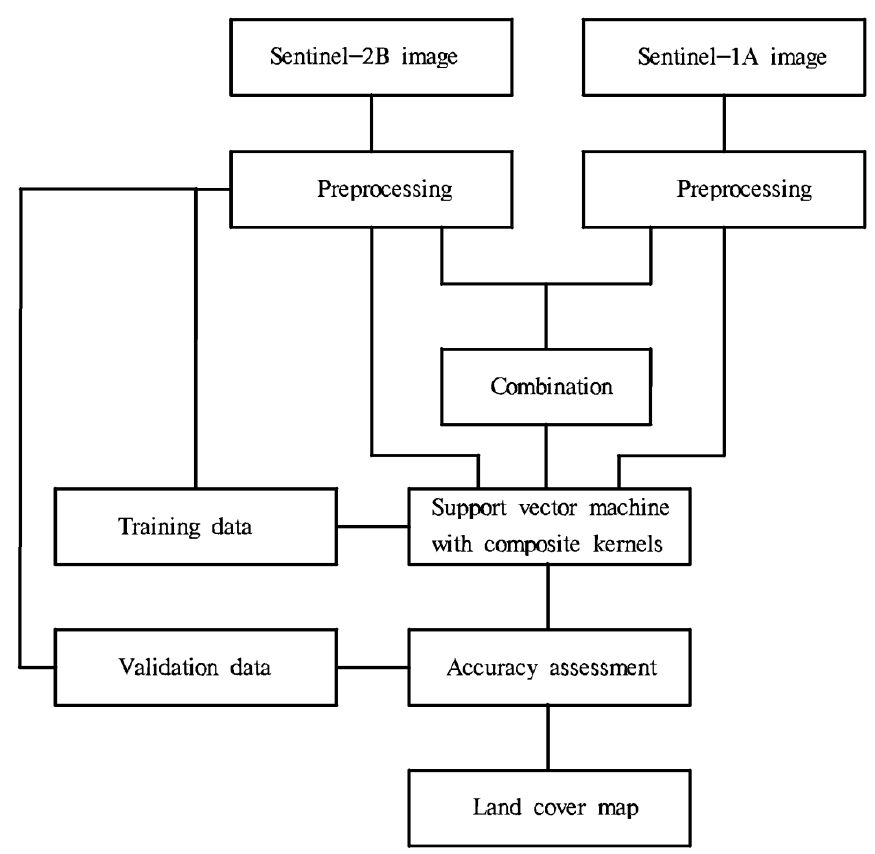
Figure 3. Flowchart of the land cover classifications in the study area.